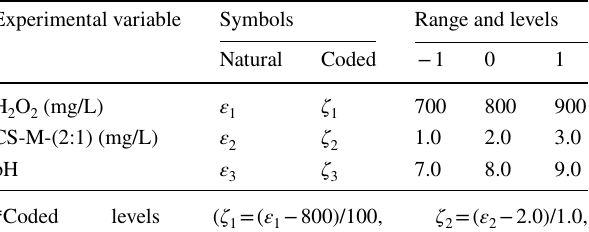
Table 1 Boundaries of Box–Behnken design, natural and coded experimental domain with their spacing of